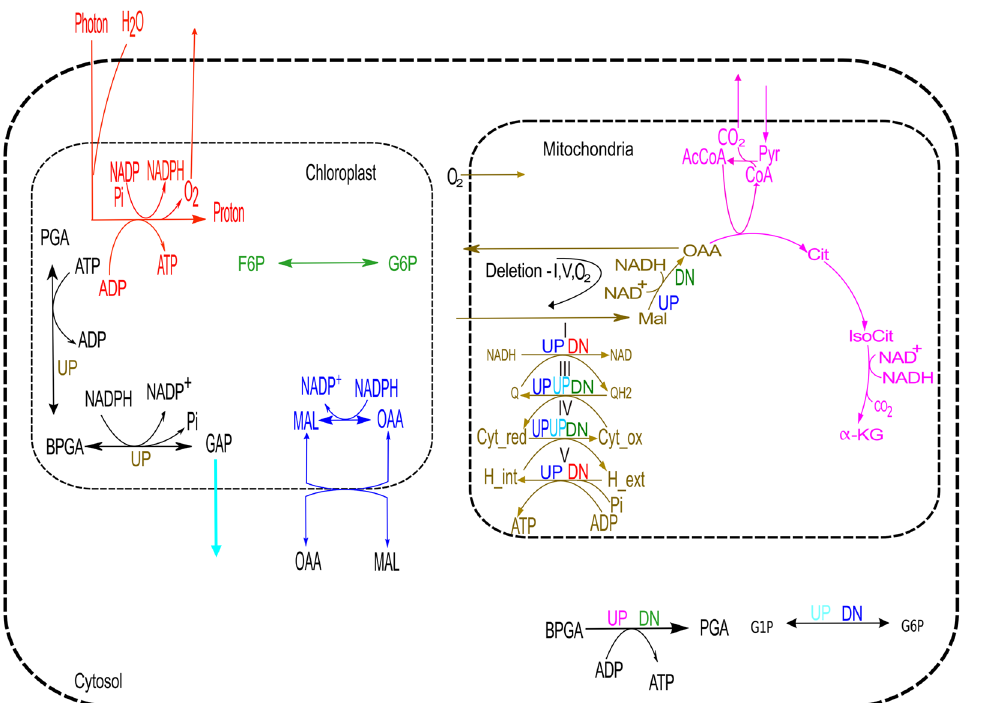
Fig 8. Up/down regulation of reactions/paths of one compartment when a reaction from another compartment is deleted. Reactions marked with UP/ DN are deleted; and the color of UP/DN shows the flux increase (UP) or decrease (DN) in another compartment. For instance, when mit_MalDH is deleted, the chloroplastic malate oxaloacetate shuttle (represented by blue UP) up regulates and the F6P to G6P conversion (represented by green DN) in chloroplast down-regulates. Malate oxaloacetate shuttle in mitochondria becomes reverse of the shown direction when complexes I, V or mitochondrial O 2 is removed. Although deletion of the reactions shown here causes high up/down regulation in flux in the same compartment or in cytosol but here we focused to observe maximum flux FC in different compartment i.e., change in mitochondria when chloroplastic reaction is deleted and vice versa. Here, CoA, Pyr, IsoCit, α -KG, AcCoA, Cit, Cyt_red, Cyt_ox, Q, QH2, MalOxAc, _ext and _int indicate Coenzyme A, Pyruvate, isocitrate, alpha ketoglutarate, Acetyl-CoA, citrate, cytochrome c reductase, cytochrome c oxidase, ubiquinone, ubiquinol, malate oxaloacetate, external and internal,